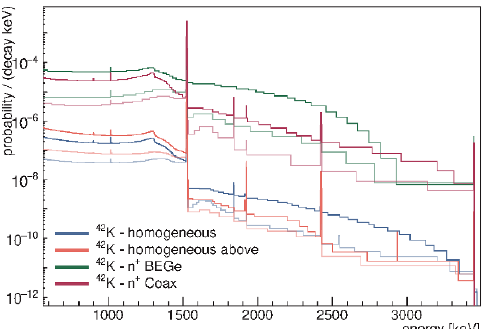
(d) 42 K contamination in di(cid:11)erent locations in- side the LAr.